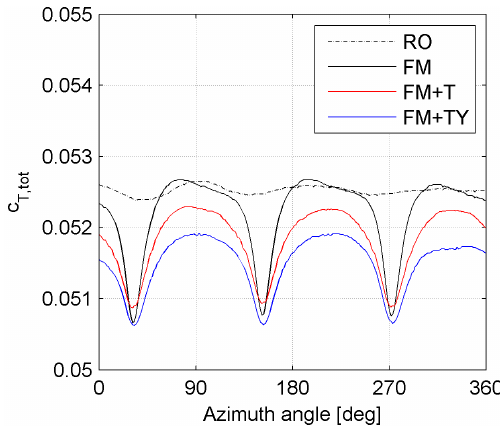
Figure 5. Total torque coefficient as a function of the azimuthal position of one blade. RO: Rotor only; FM: Full machine; FM + T: Full machine (with tilt); FM + TY: Full machine (with tilt and yaw).